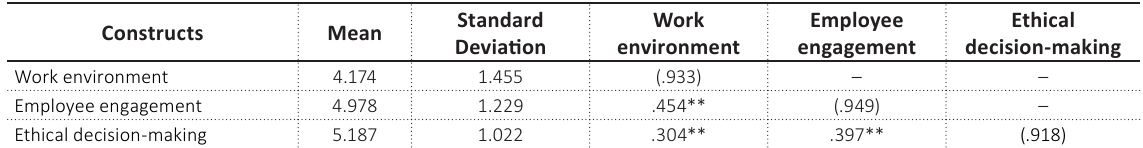
Table 2. Descriptive statistics, reliability, and inter-correlations